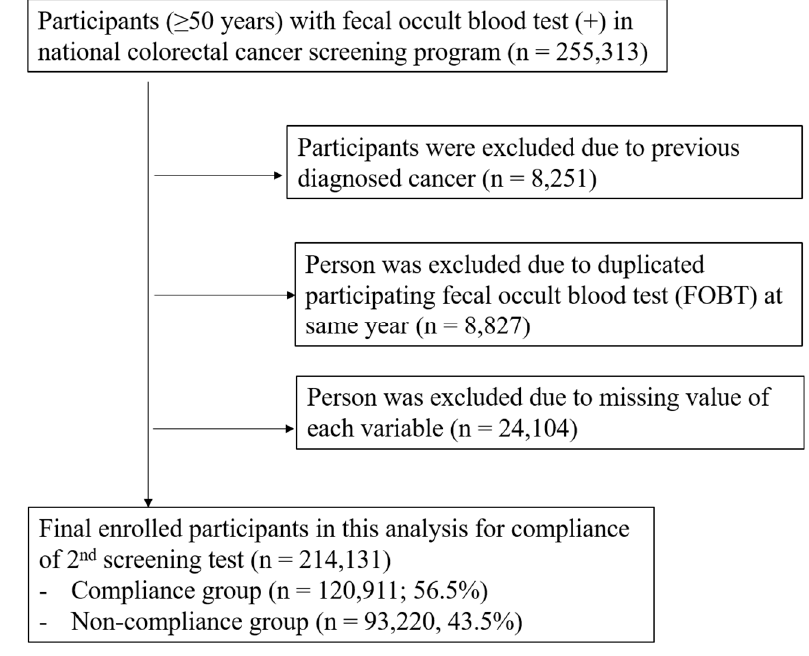
Figure 1. Flow diagram of the study population.